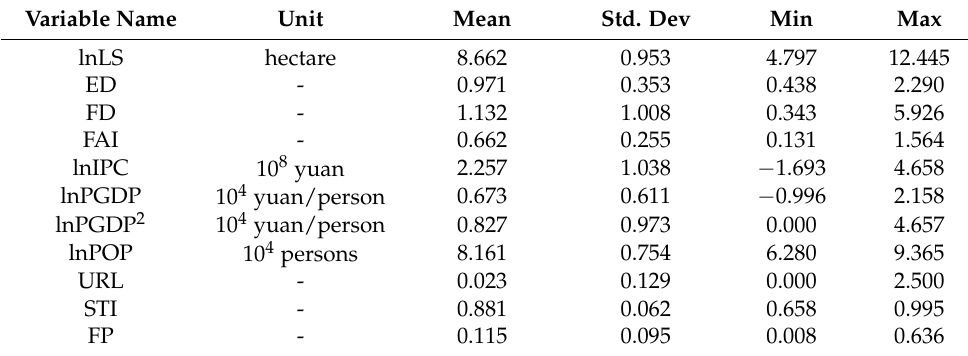
Table 2. Descriptive statistics of variables.